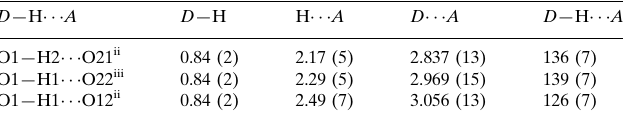
Hydrogen-bond geometry (A˚ , (cid:3)